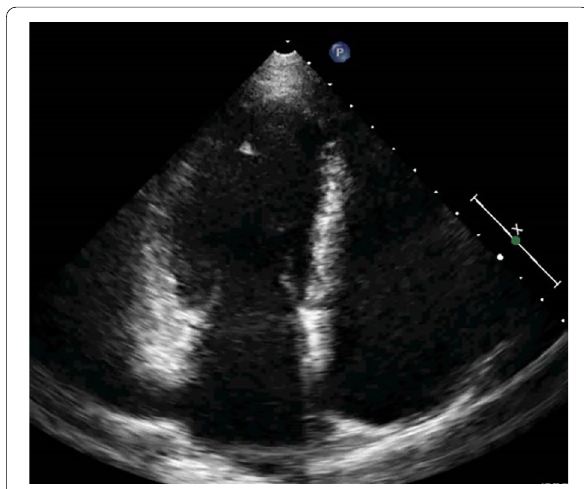
Fig. 5 Control transthoracic echocardiogram in apical four-chamber view shows complete resolution of intramural